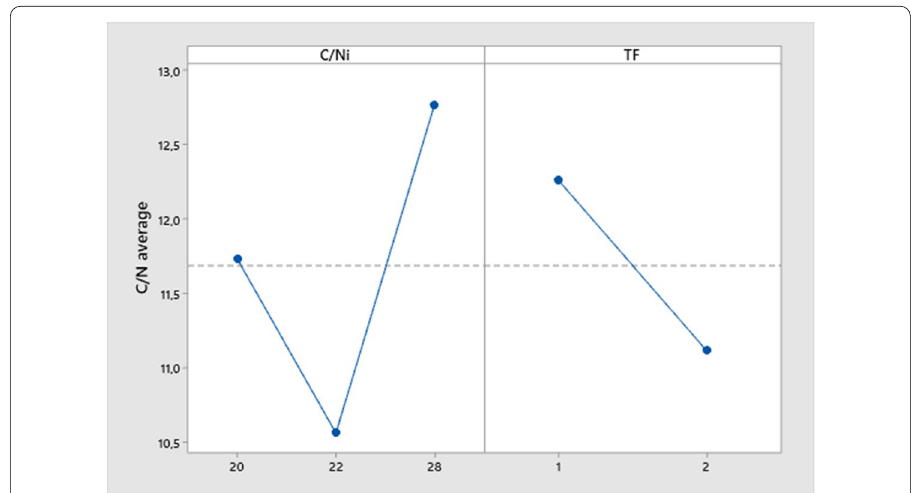
Fig. 9 Effect diagram of C/Ni and TF on